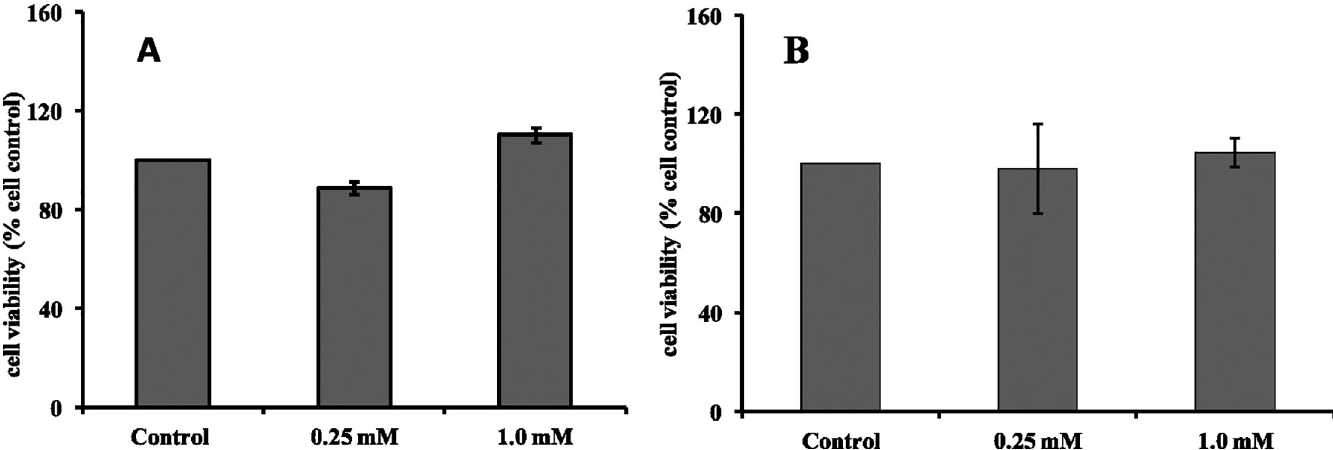
Fig 6. Effect of calcium glucoheptonate on epithelial cells. (A) colorectal epithelial cells (Caco2) and (B) renal epithelial cells (HEK 293T).